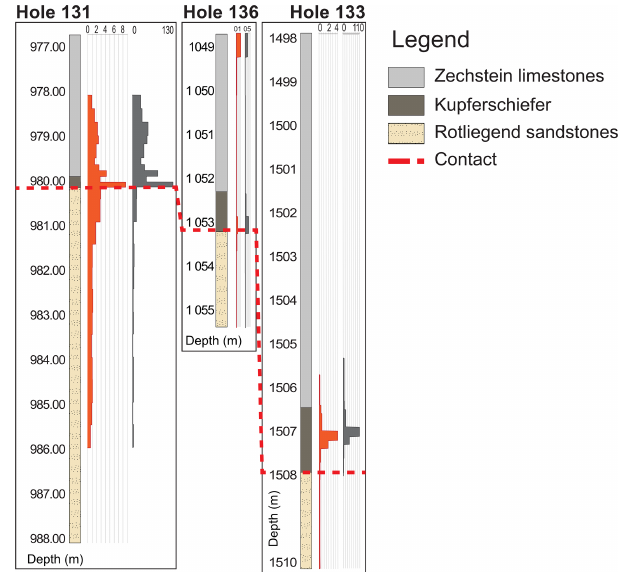
Figure 3. Lithology, copper (red in wt%), and silver (grey in gt − 1 ) grades in the drill cores available for this